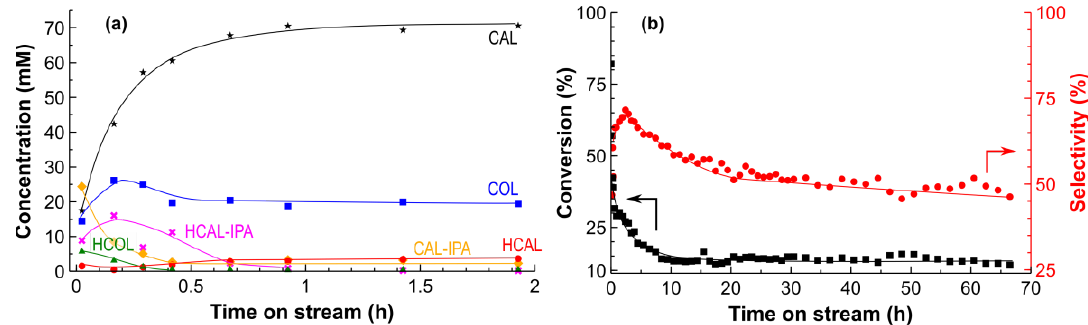
Figure 12. The stability test of a continuous fixed bed reactor packed with 190 mg 12 wt % Pt/SiO 2 . Reaction conditions: H 2 flow rate: 3 mL min − 1 , liquid flow rate: 0.2 mL min − 1 , CAL concentration: 0.8